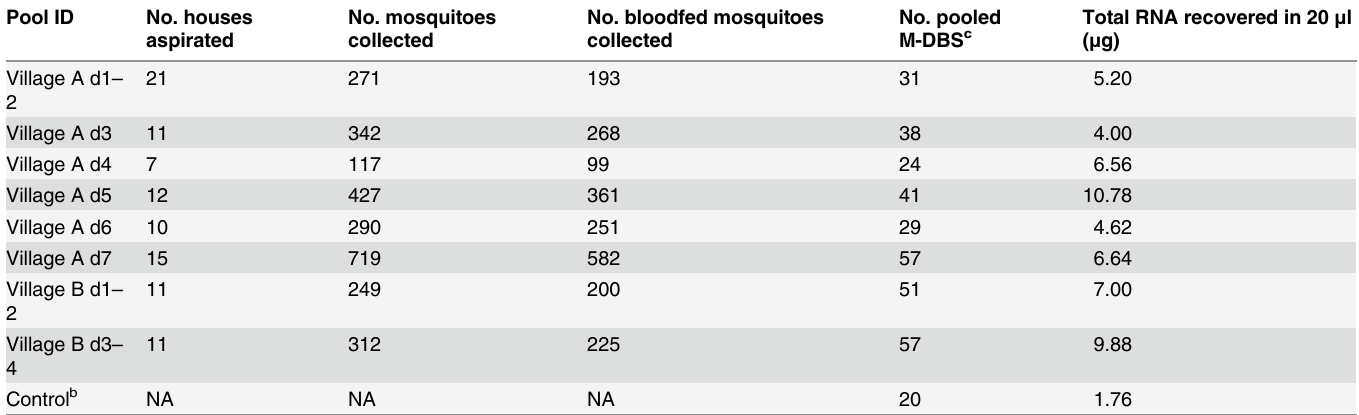
Table 2. Liberia mosquito collection summary a and RNA-sequencing pools. Pool